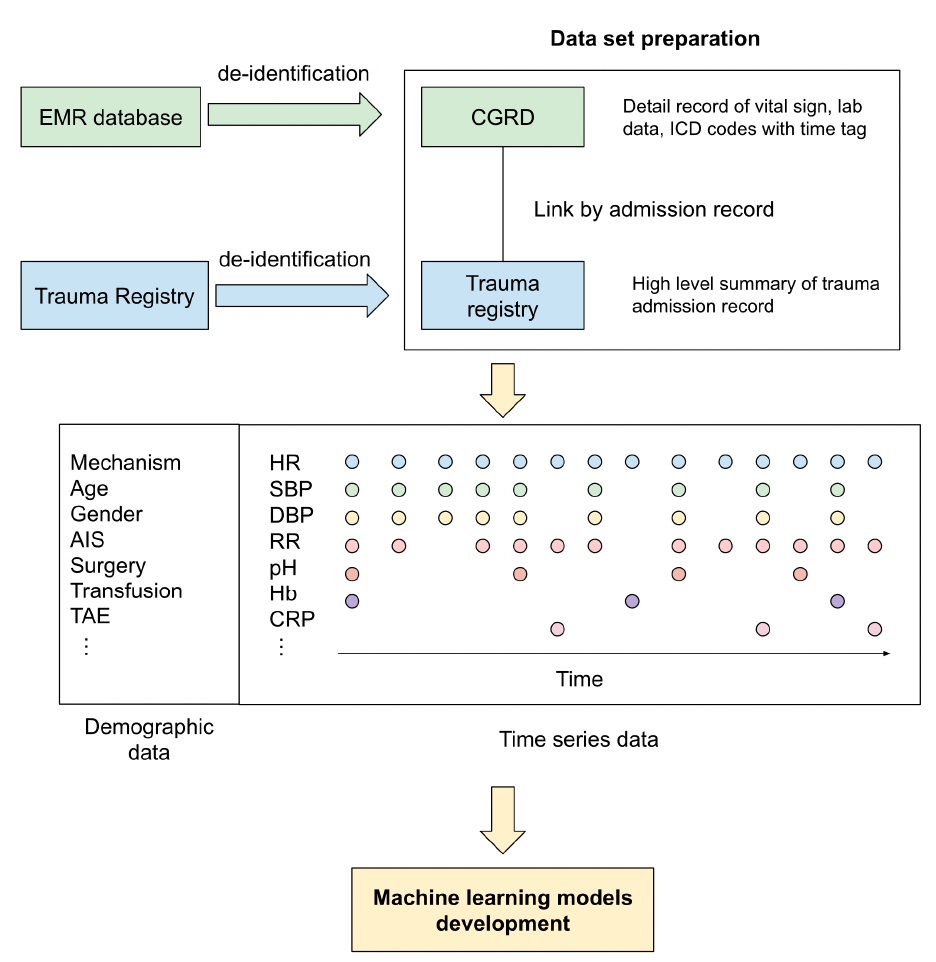
Figure 1. The data set preparation schema in the current study.